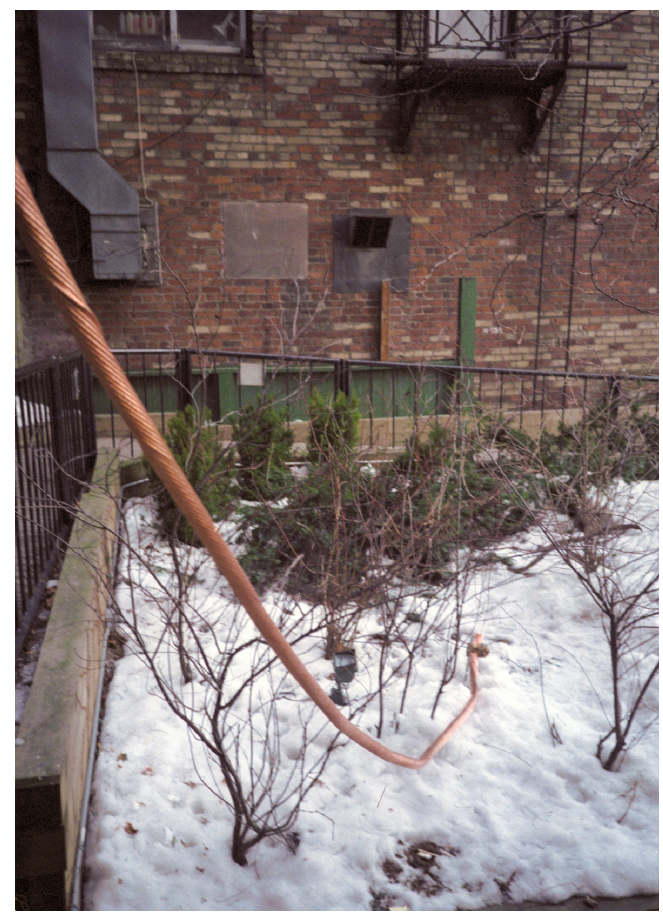
Figure 2: Richards, Cabinet of Curiosities at the End of the Millennium , detail. Photograph courtesy of the